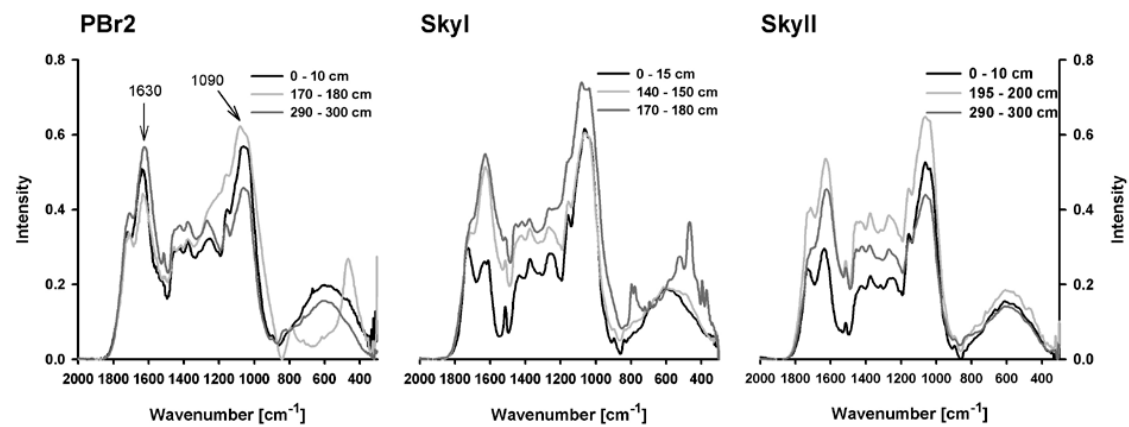
Fig. 3. FTIR-spectra of peat samples from the three bogs in different depths. Chosen samples represent upper, less decomposed peat Figure 3: FTIR-spectra of peat samples from the three bogs in different depths. Chosen 2 (0–10cm), deeper, highly decomposed peat and samples influenced by ash layer or underlying sediment (Pbr2 170–180cm and SkyI 170– samples represent upper, less decomposed peat (0-10 cm), deeper, highly decomposed peat 3 and samples influenced by ash layer or underlying sediment (Pbr2 170-180 cm and SkyI 170-4 180 cm). 5